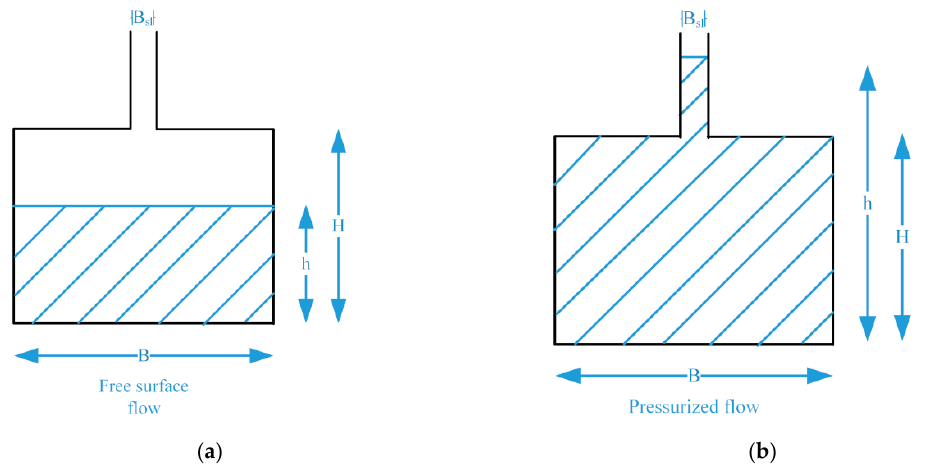
Figure 1. A rectangular conduct with a slot on its top: ( a ) free surface flow; ( b ) pressurized flow.